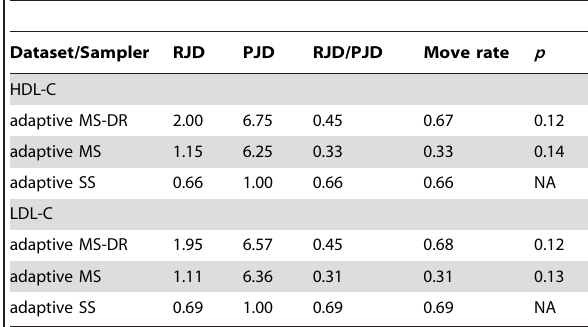
Figure 6. ESS/time in the HDL-C and LDL-C datasets. Boxes show the variation over the 12 independent MCMC chains for each sampler. ESSs are computed for the c samples. Red dots show geometric means. 1=adaptive MS-DR, 2=adaptive MS, 3=adaptive SS. Note that the LDL- C samplers have not converged to same posterior distribution and thus the comparison is not valid.